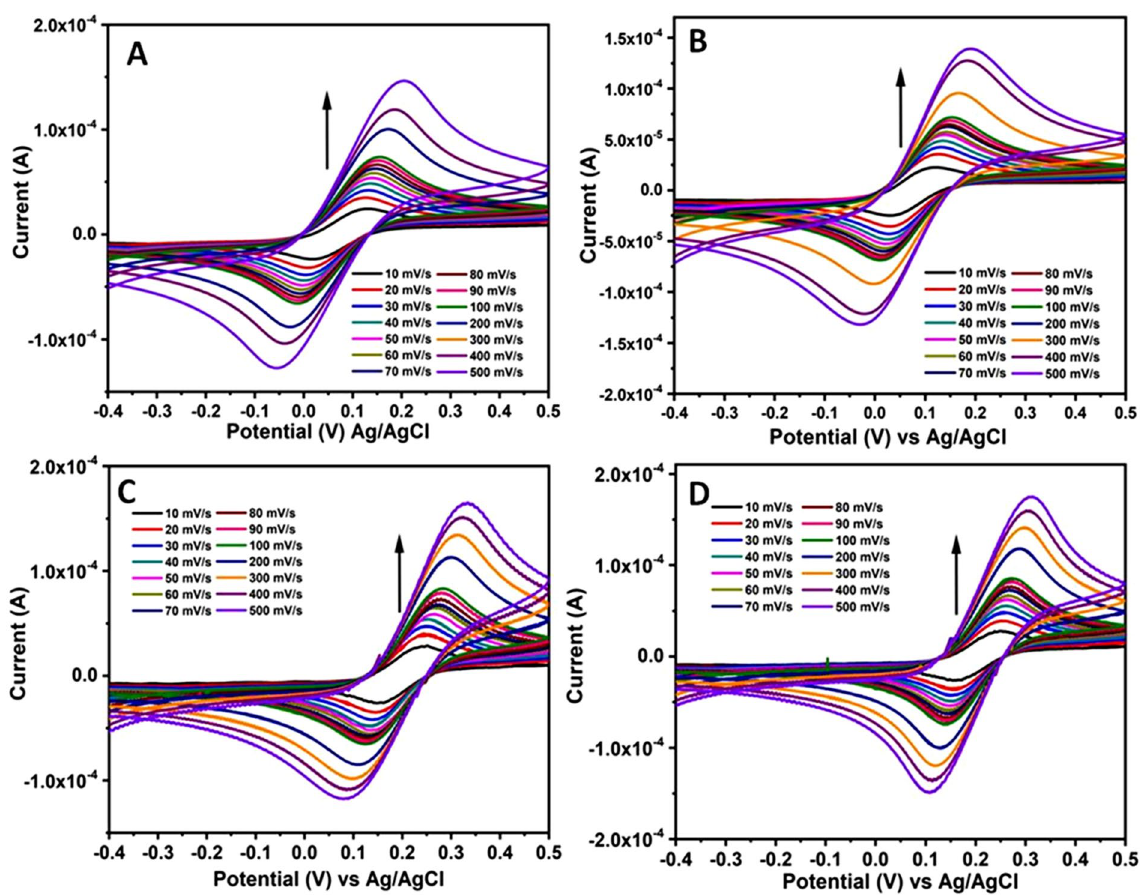
Figure 4. CV curves recorded for Au and Pt electrodes using sweat and saliva bio-mimic solutions over a wide range of scan rate from 10 to 500 mV/s. ( A ) Au and ( B ) Pt electrodes studied in artificially simulated sweat solution + Fe 2+/3+ redox couple. Similarly ( C ) Au and ( D ) Pt electrodes investigated in artificial saliva solution + Fe 2+/3+ redox couple. These CVs are recorded for 1 mM [Fe(CN) 6 ] 3−/4− redox couple containing 0.1 M NaCl as the supporting electrolyte. In these figures arrows indicate the direction of increasing scan